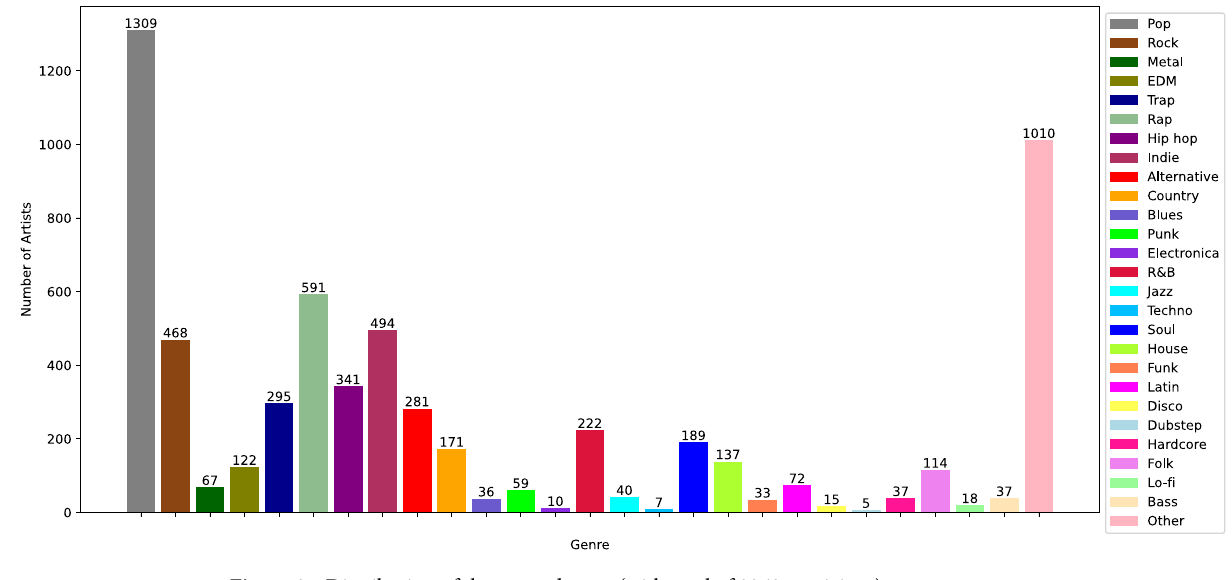
Figure 2. Distribution of the genre dataset (with total of 2363